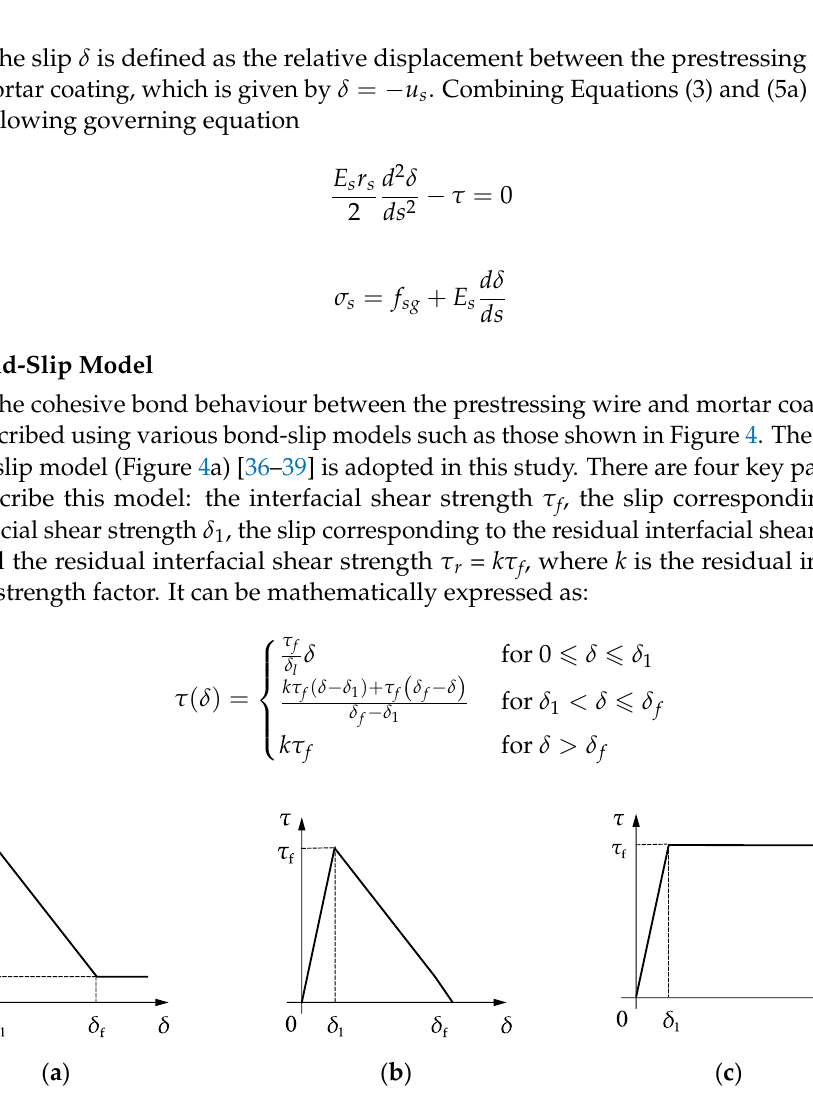
Figure 4. Bond-slip models: ( a ) Tri-linear model; ( b ) Bi-linear model; ( c ) Ideal elastoplastic